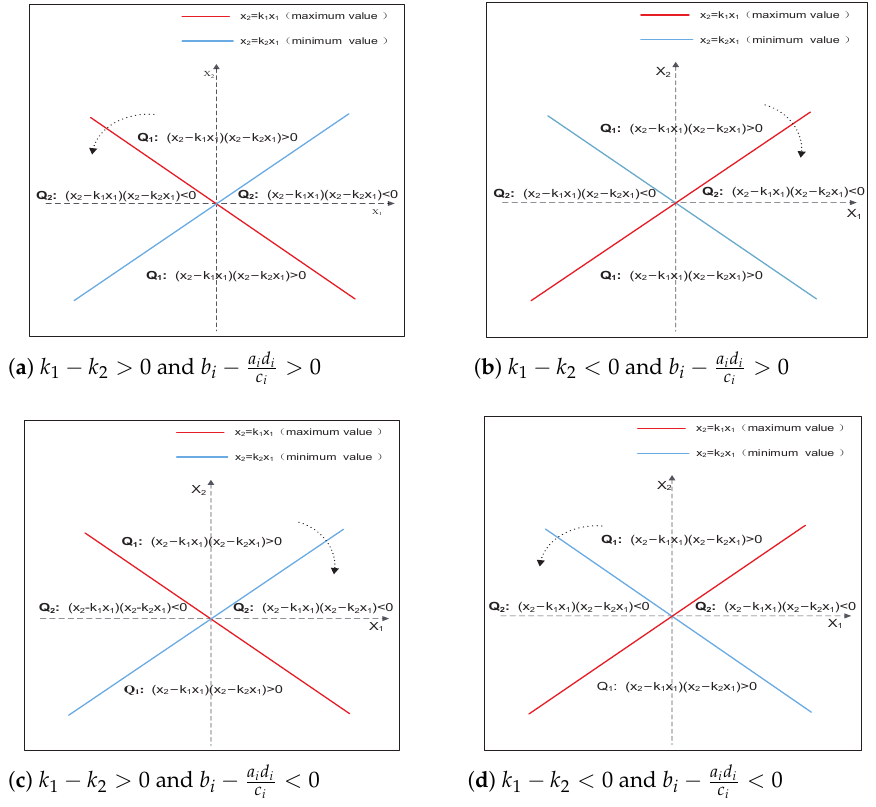
Figure 1. A diagram of system switching for different cases given in